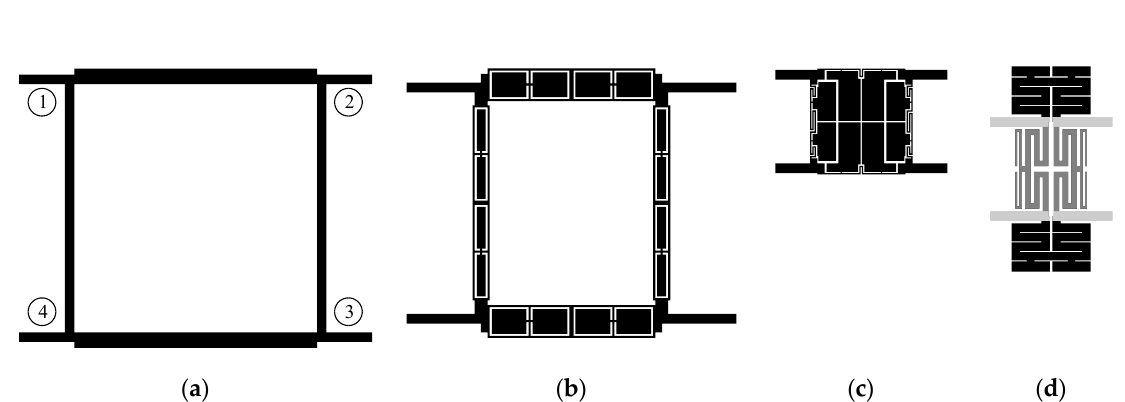
Figure 1. Comparison of microstrip equal-split branch-line couplers in terms of size: ( a ) A conventional structure [58], as well as circuits ( b ) miniaturized using standard symmetrical cells (size reduction: 30%) [53], ( c ) manually developed cells (reduction: 84%) [24], and ( d ) a combination of horizontal (black) and vertical (dark gray) CCs (reduction: 75%). Due to the implementation of couplers on different substrates, miniaturization rates are calculated based on dimensions expressed in terms of guided wavelength [61]. Numbers in circles next to the conventional design denote the enumeration scheme of BLC ports that is used in the work.